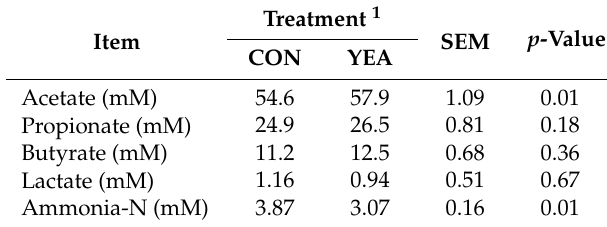
Table 5. Rumen fermentation of beef steers fed no or 15 g/d of live yeast product.